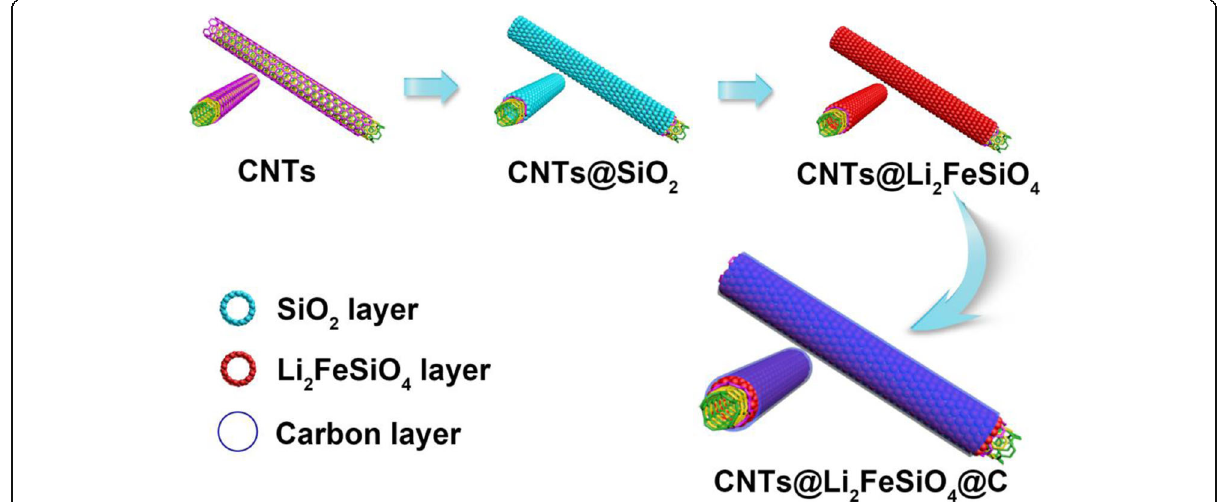
Fig. 1 Schematic diagram of synthesis of the core-shell heterostructure CNT@Li 2 FeSiO 4 @C